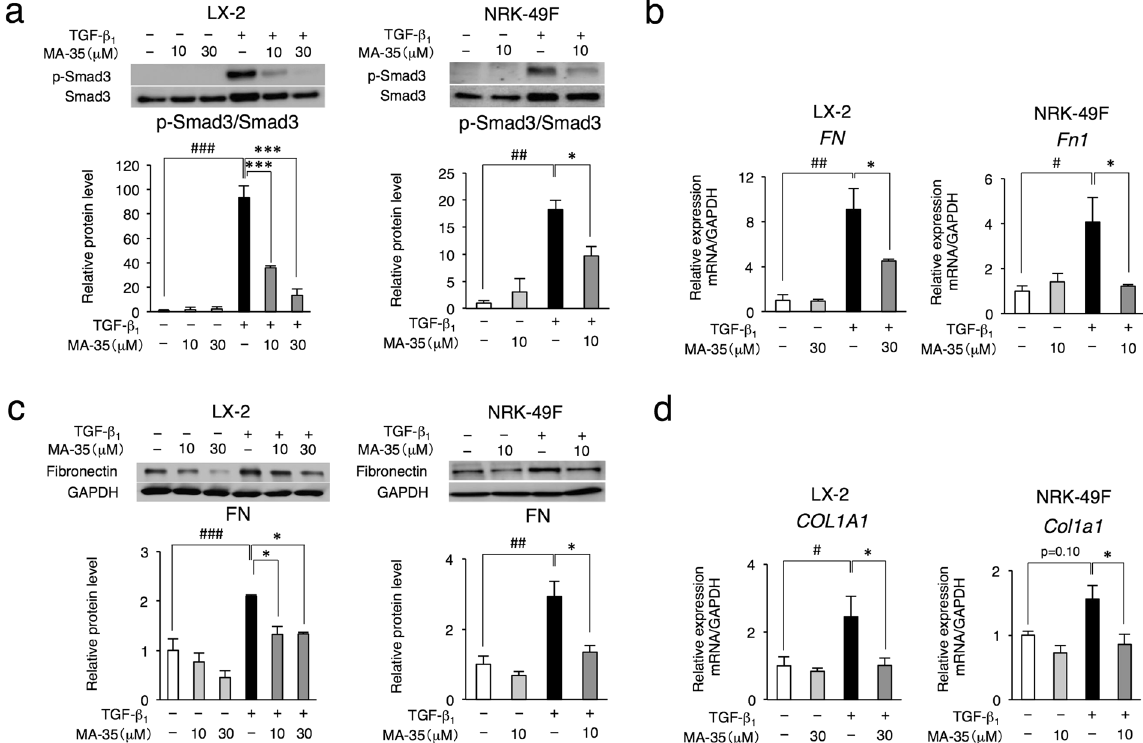
Figure 4. Effect of MA-35 on TGF- β 1 -induced Smad3 phosphorylation and fibrotic gene expression in LX-2 cells and NRK-49F cells. Serum-starved LX-2 and NRK-49F cells were treated with or without TGF- β 1 (5 ng/mL and 2 ng/mL, respectively) in the presence or absence of MA-35 for ( a ) 30 min, ( b right ) ( d right ) 12 h, ( b left ) ( d left ) 24 h and ( c ) 48 h. ( a ) Expression levels of p-Smad3 were quantified by densitometry and normalized with Smad3. Full-length gel was shown in Supplementary Fig. 6. The mRNA level of ( b ) FN, Fn1 and ( d ) COL1A1 , Col1a1 were measured by real-time PCR. ( c ) Expression levels of fibronectin were quantified by densitometry and normalized with GAPDH. Full-length gel was shown in Supplementary Fig. 7. # p < 0.05, ## p < 0.01, ### p < 0.001 v.s. Control, * p < 0.05, *** p < 0.001 v.s. TGF- β 1